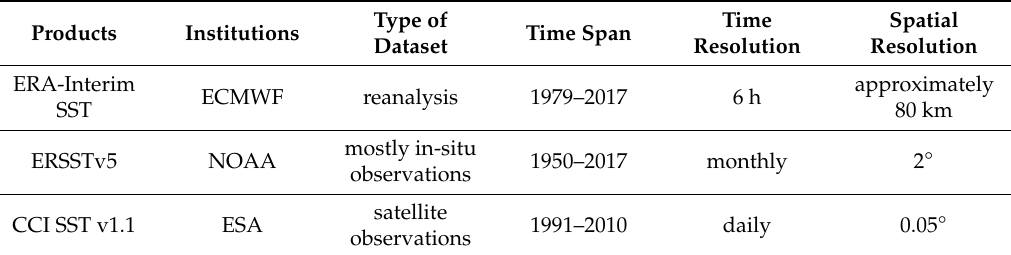
Table 5. Data used for the pricing of the insurance product.